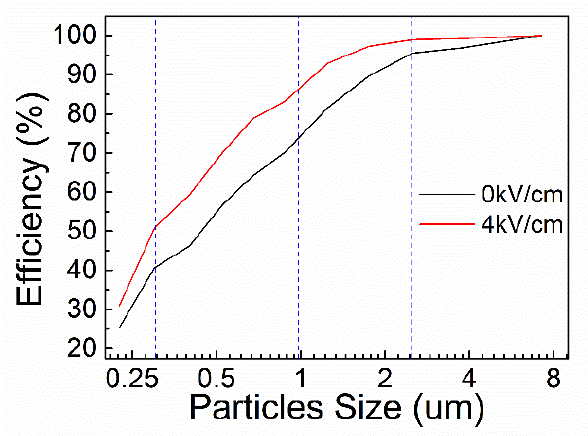
Figure 7. Filtration efficiency of melt-blown fabric and electrostatic-assisted melt-blown fabric. Table 1. Filtration efficiencies of different particle sizes.